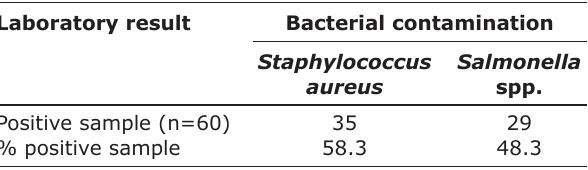
Table-1: Results of bacterial contamination in chicken meat. Laboratory result